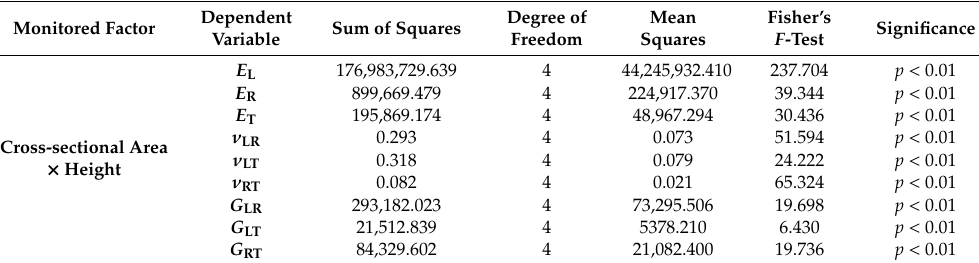
Table 4. ANOVA of interaction of cross-sectional area with height.